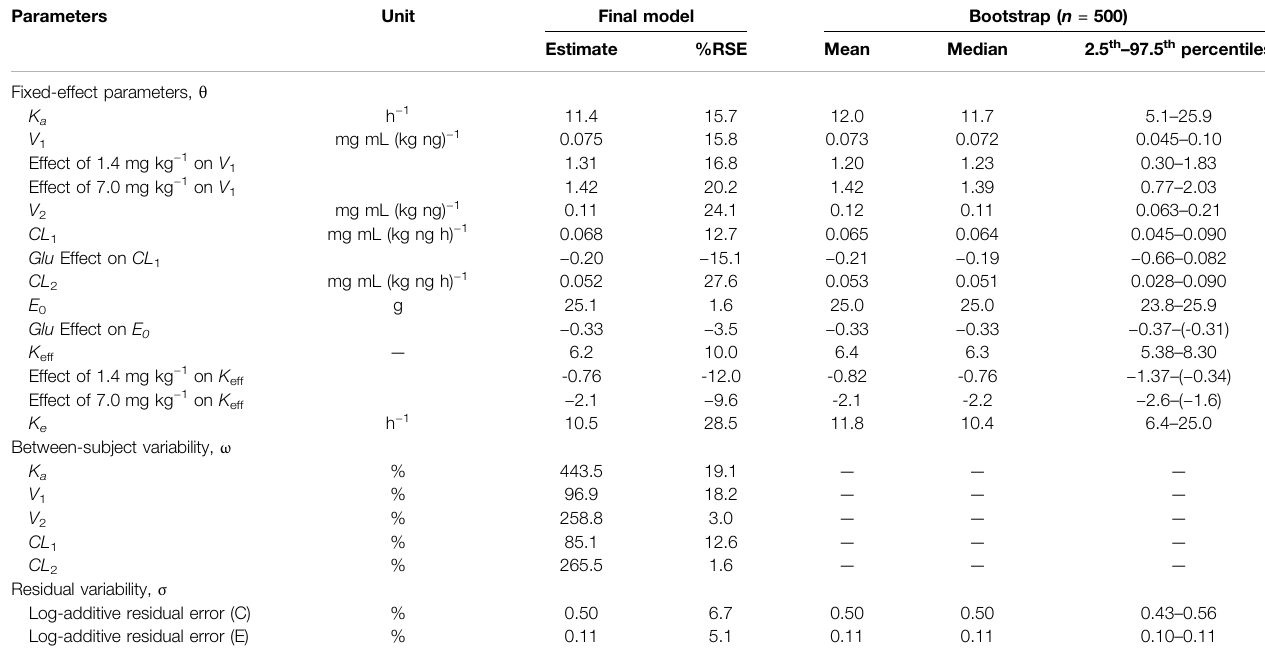
TABLE 2 | Population PK and PD parameters calculated by fi tting the model to the observed data after the oral administration of KM (0.28, 1.4, or 7.0 mg kg − 1 ) along with bootstrap validation. Parameters Unit Final model Bootstrap ( n = 500) Estimate